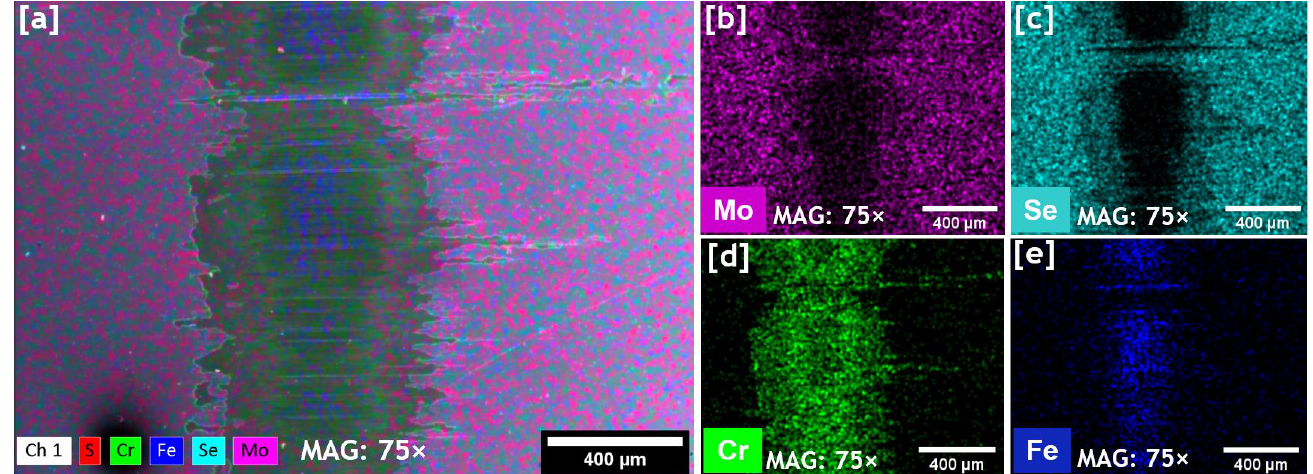
Figure 13. ( a ) SEM/EDS mapping showing the chemical composition distribution for the coated specimen MoSeC; ( b ) Mo coming from the coating; ( c ) Se coming from the coating; ( d ) Cr from the coating interlayer and ( e ) Fe from the substrate.